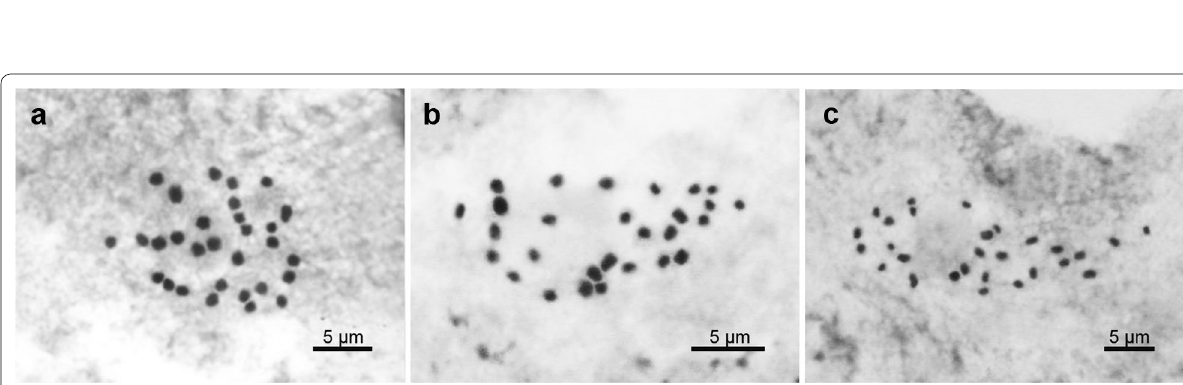
30, Peng et al . 23794 ); b B. merrilliana (2 n =